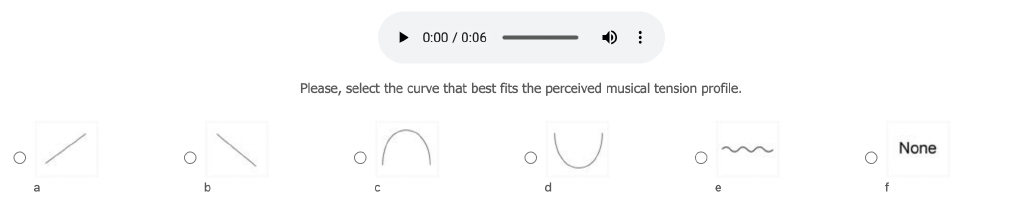
Figure 4. Question of the listening